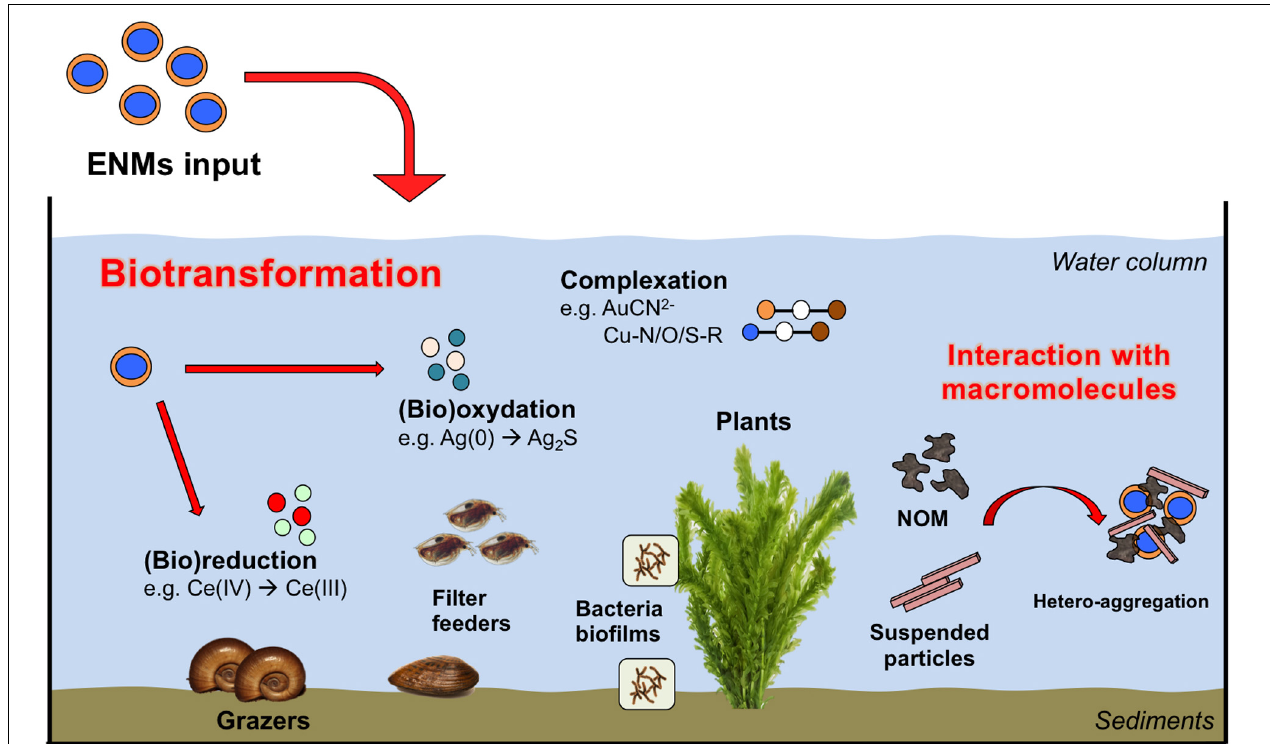
FIGURE 4 | Major ENPs (bio)transformation pathways observed in aquatic mesocosms